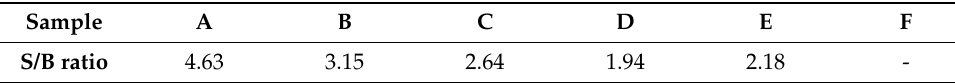
Figure 9. ( a ) The SERS intensities with R6G concentration between 10 −5 to10 −10 M in Sample C. The limit of detection (LOD) observed was lower at 10 −8 M. ( b ) A comparison of the Raman spectra be- tween Sample C for measuring the 10 −6 M R6G analyte and a pure glass slide for 10 −1 M. 3.5. Reproducibility and Storage of SERS Substrates Reproducible, reliable efficacy, and performance signals are other essential factors to evaluate the SERS substrates. Hence, five random samples of Sample C were dropped in a 10 −6 M aqueous R6G solution on five random positions of each substrate to check the repeatability and sensitivity. Figure 10a shows all of the 25 SERS intensities from 610 to 615 cm −1 . The average intensity and the RSD value for Sample C were 46,700 and 1.61%, respectively.